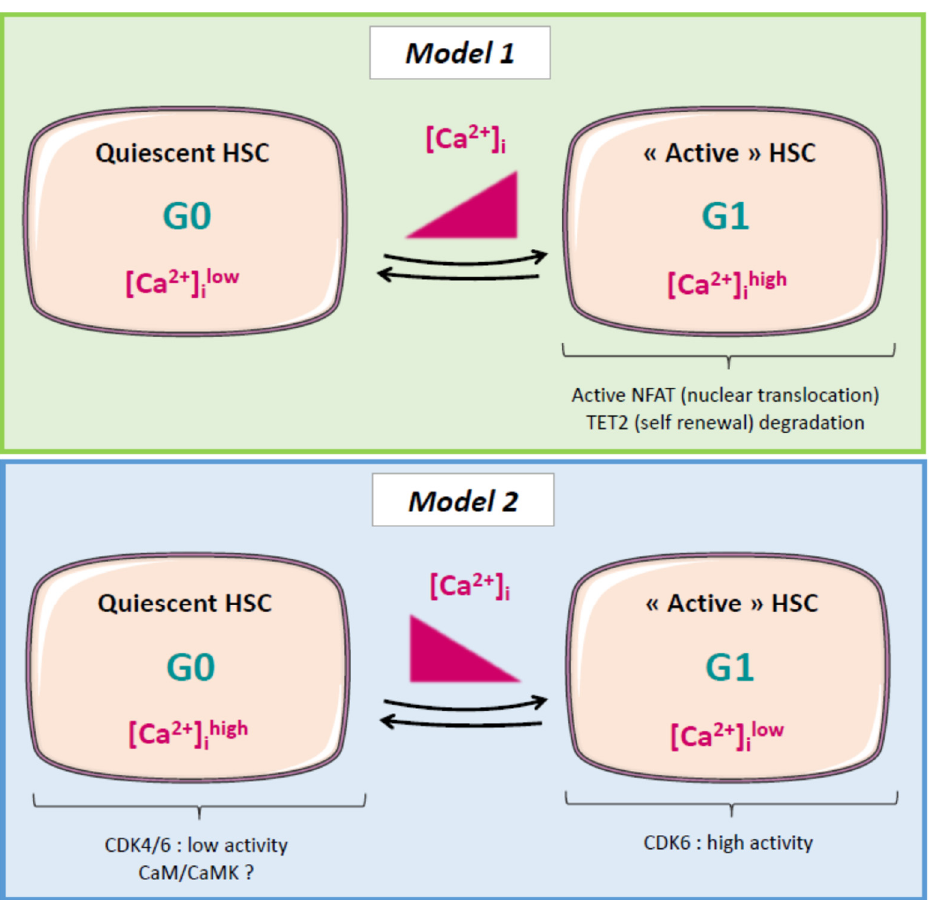
Figure 1. Schematic diagram illustrating the two proposed models of calcium-dependent mechanisms controlling the switch between quiescence and cycling state in HSC. In model 1 [42] and model 2 [9], quiescent hematopoietic stem cells (HSC) display distinct features compared to the cycling/active HSC. In model 1, intracellular Ca 2+ concentration increases during the switch from G0 to G1 state. Active HSC display active NFAT and TET2 degradation. In model 2, it is proposed that intracellular Ca 2+ concentration decreases during G0 to G1 transition, leading to an increase in CDK4/6 activities, and that the calmodulin (CaM)/CaM kinase (CaMK) pathway is involved in HSC quiescence.